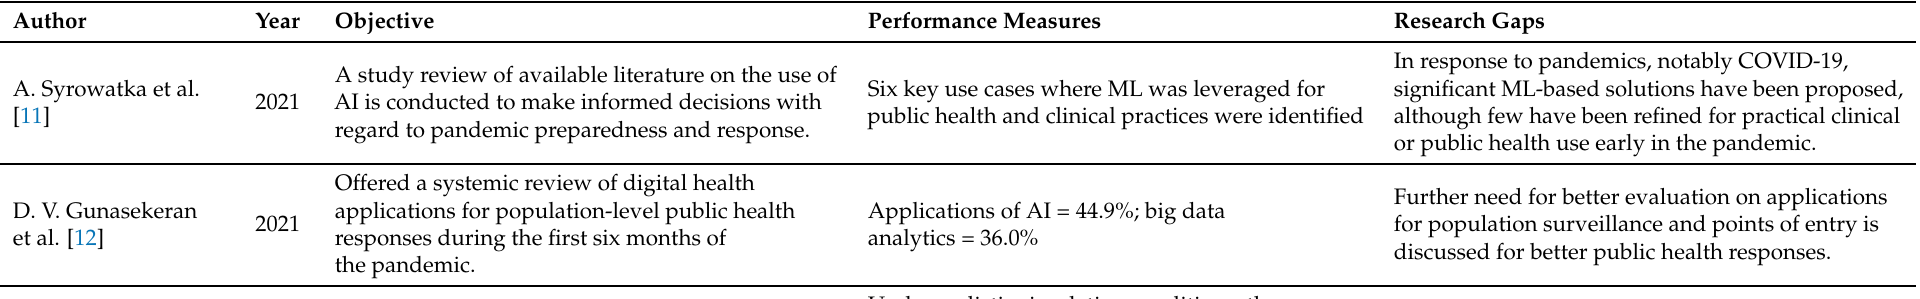
Table 1. A relative comparison of various state-of-the-art approaches for the detection and early diagnosis of the COVID-19